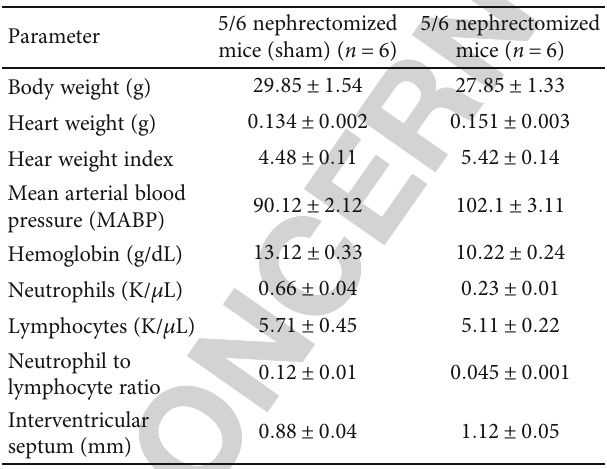
Table 1: Combined data for all the groups prior to sepsis and 5/6